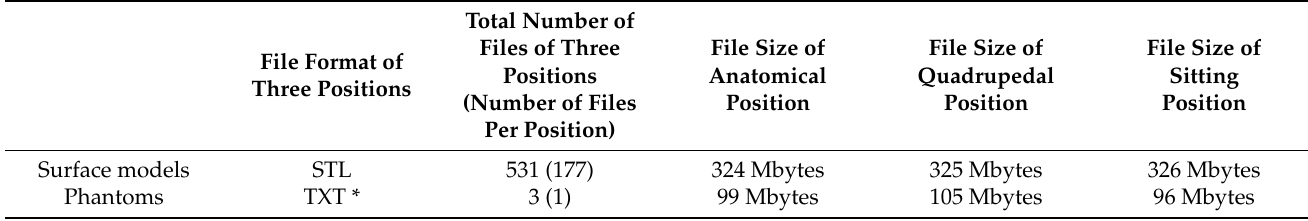
Three monkey phantoms, i.e., in anatomical (Figure 3b), quadrupedal (Figure 3d), and sitting (Figure 3f) positions, were stored in TXT format (Table 1). In the TXT files for the three positions, the coordinates (x-, y-, z-axes) and ID of each structure